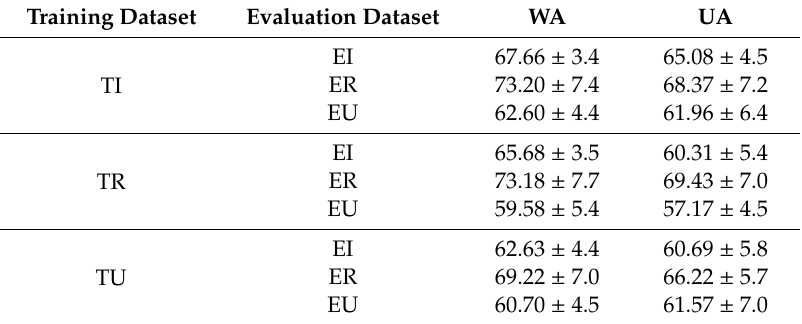
Table 5. Results of the ALA model for improvised (I), more reliable (R), and less reliable (U)